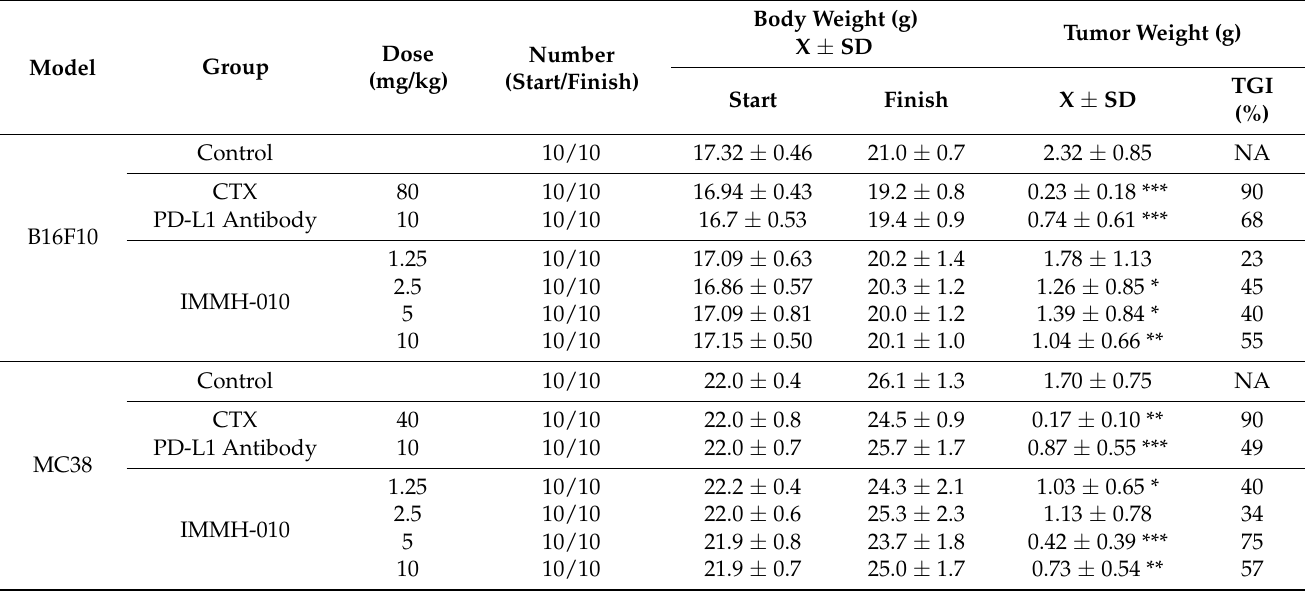
Table 1. Effects of IMMH-010 on the body weight and tumor growth in B16F10 and MC38 models after administration for 19 days.